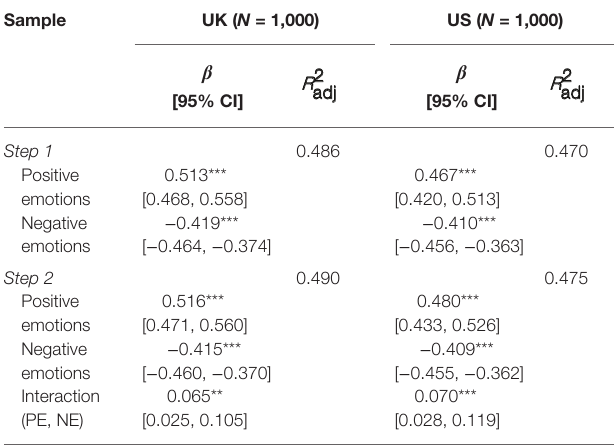
TABLE 1 | Standardized weights of positive emotions, negative emotions, and their interaction component, in accounting for individual differences in cultivating a resilient mindset during the COVID-19 pandemic, using separate linear hierarchical regression analyses for the UK and the US samples ( N total =